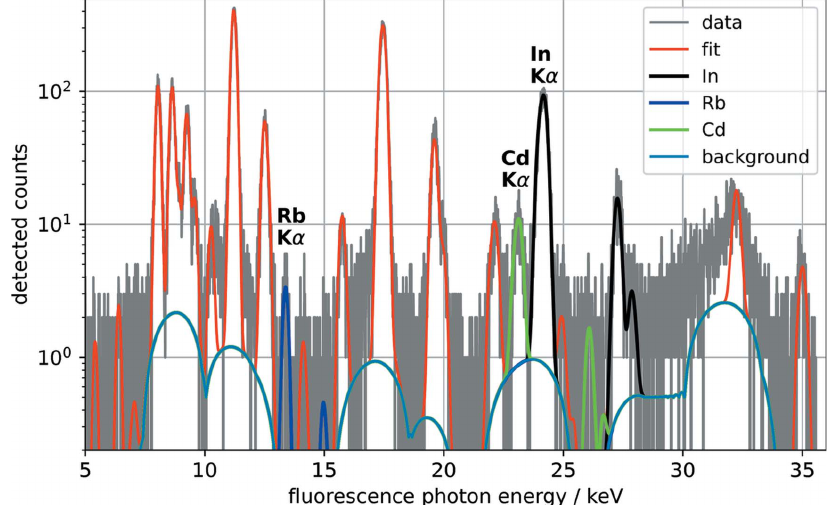
and In) are highlighted.